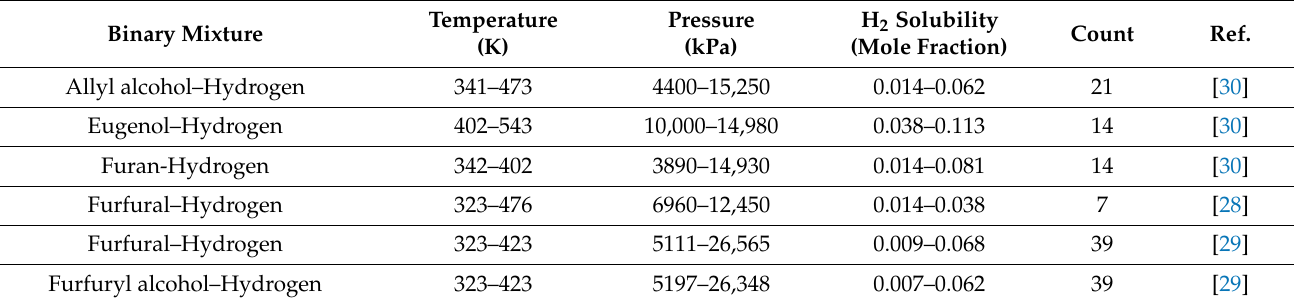
Table 1. Summary of the literature data for hydrogen solubility in